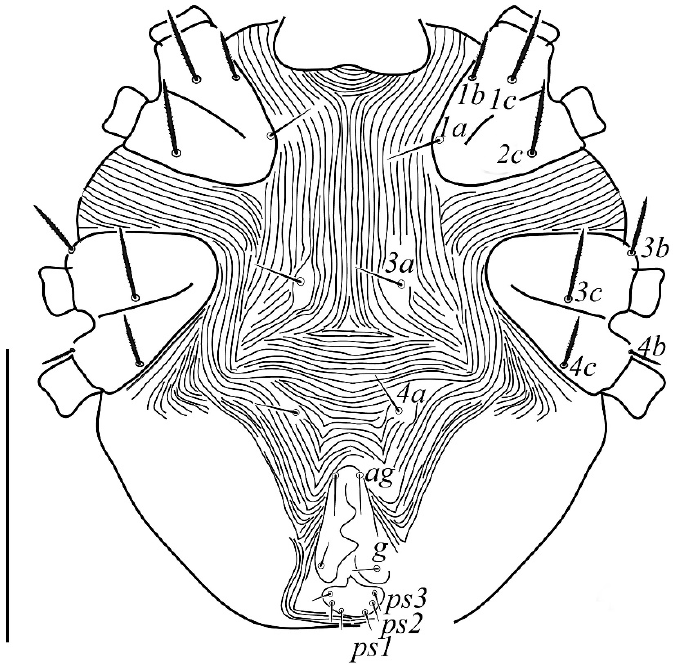
Figure 4. Neophyllobius combreticola . Female. Venter. Scale bar: 100 μ m.